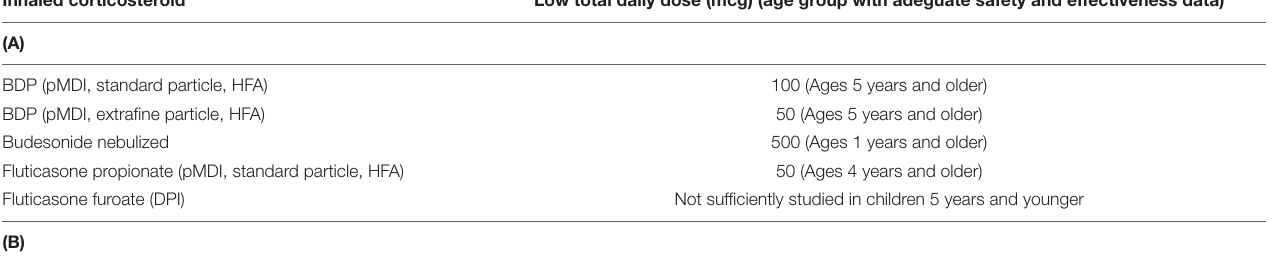
TABLE 2 | Limit dose for adeguate safety of the inhaled corticosteroids for age group (2). Inhaled